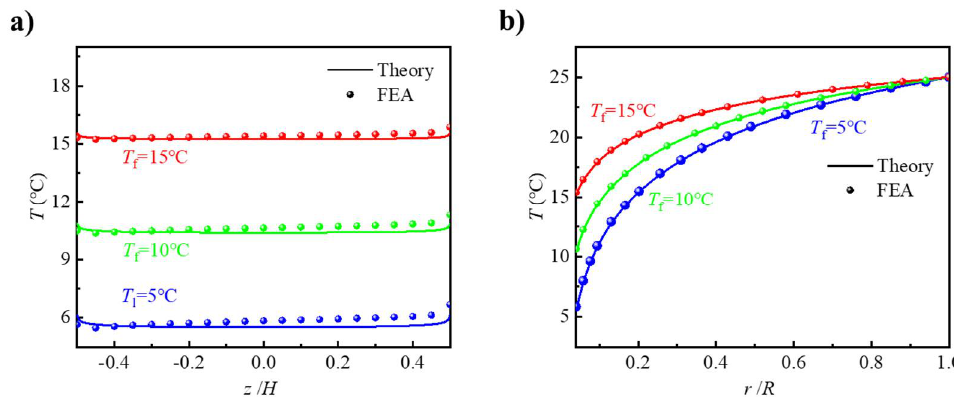
Figure 4. Temperature distributions along ( a ) Path 2 and ( b ) Path 3.